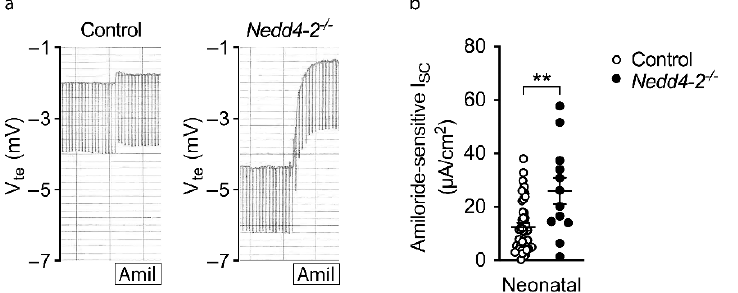
Figure 6. Increased ENaC activity in congenital Nedd4-2 −/− mice: ( a ) Representative Ussing chamber recordings of the effect of amiloride (Amil) on transepithelial voltage (V te ) and resistance (R te ) of freshly excised tracheal tissues from a 10-day-old congenital Nedd4-2 −/− mouse and a littermate control. ( b ) Summary of amiloride-sensitive short circuit current (I SC ) across freshly excised airway tissues of 10-day-old congenital Nedd4-2 − / − and control mice. n = 12–43 mice per group. ** p < 0.01. Data are shown as mean ±